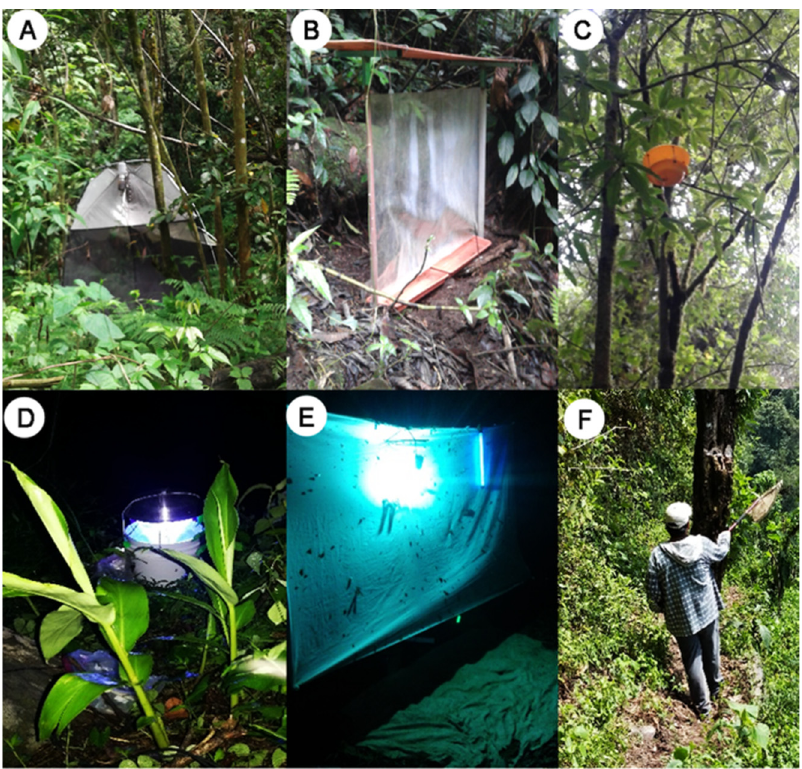
Figure 1. Different types of sampling methods implemented in this study: ( A ) Malaise trap; ( B ) ground-level interception traps; ( C ) yellow plate traps; ( D ) black light trap; ( E ) white light trap; ( F ) entomological net.